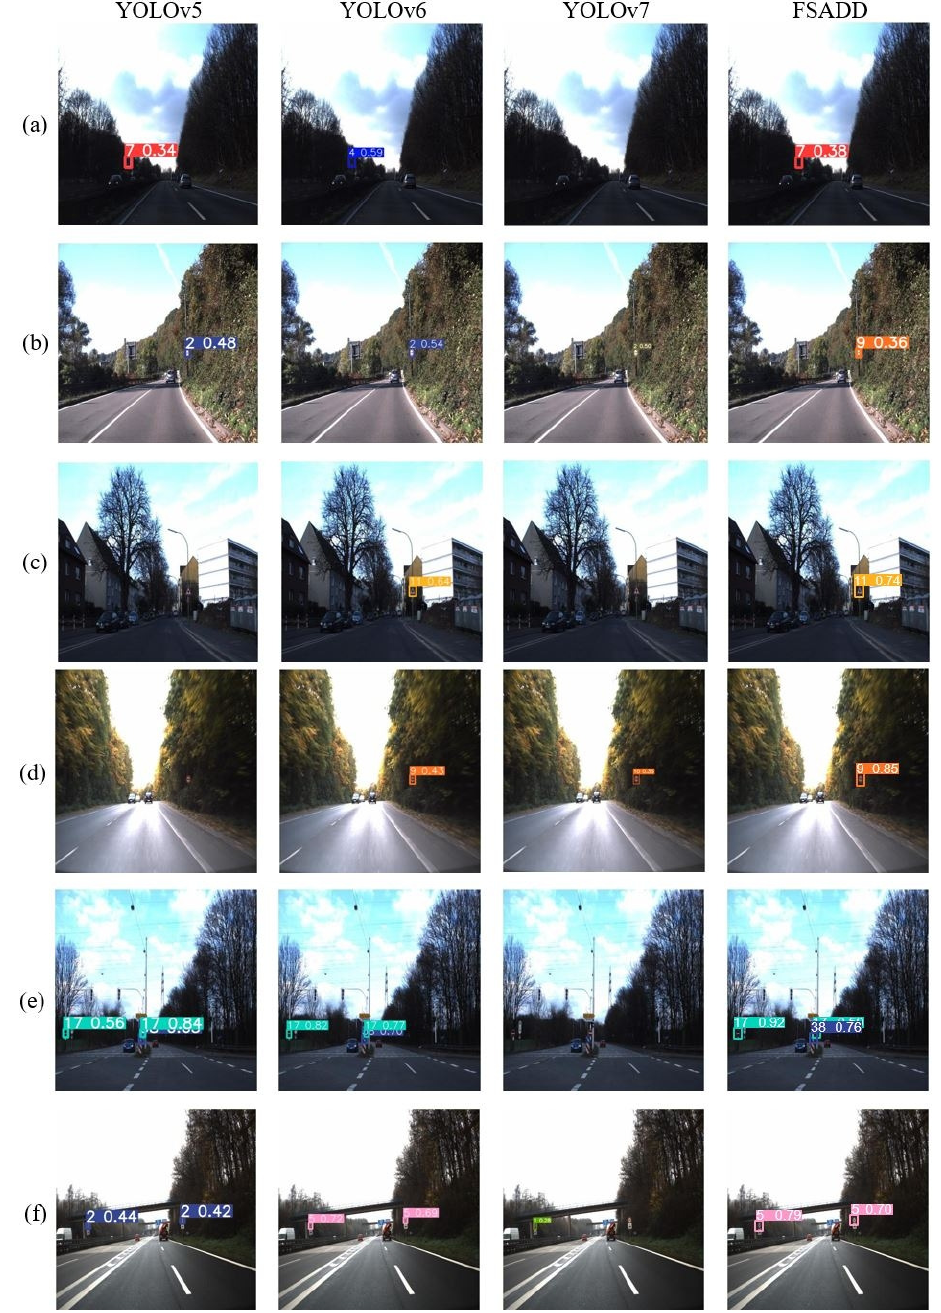
Figure 10. Traffic sign detection performance comparisons (YOLOv5, YOLOv6, YOLOv7, and FSADD)—Part 2: ( a ) ground truth—7, ( b ) ground truth—9, ( c ) ground truth—11, ( d ) ground truth—9, ( e ) ground truth—17 and 38, and ( f ) ground